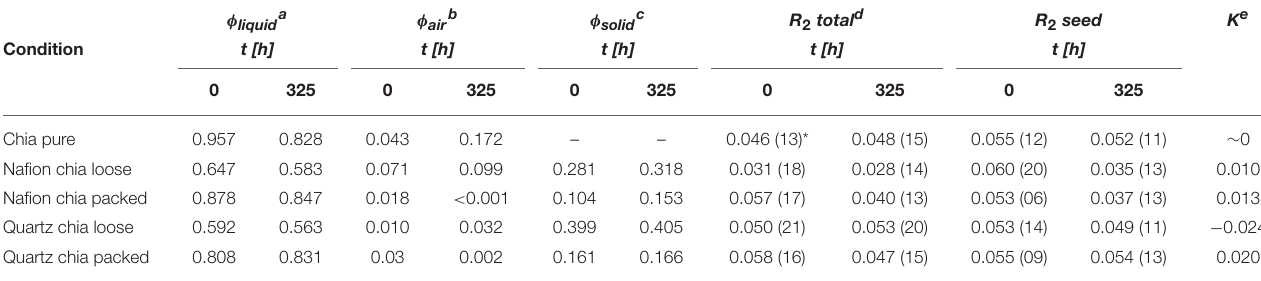
TABLE 1 | Estimated volume fractions of the different materials within the XCT imaged regions of interest at time points t = 0h and t = 325h.